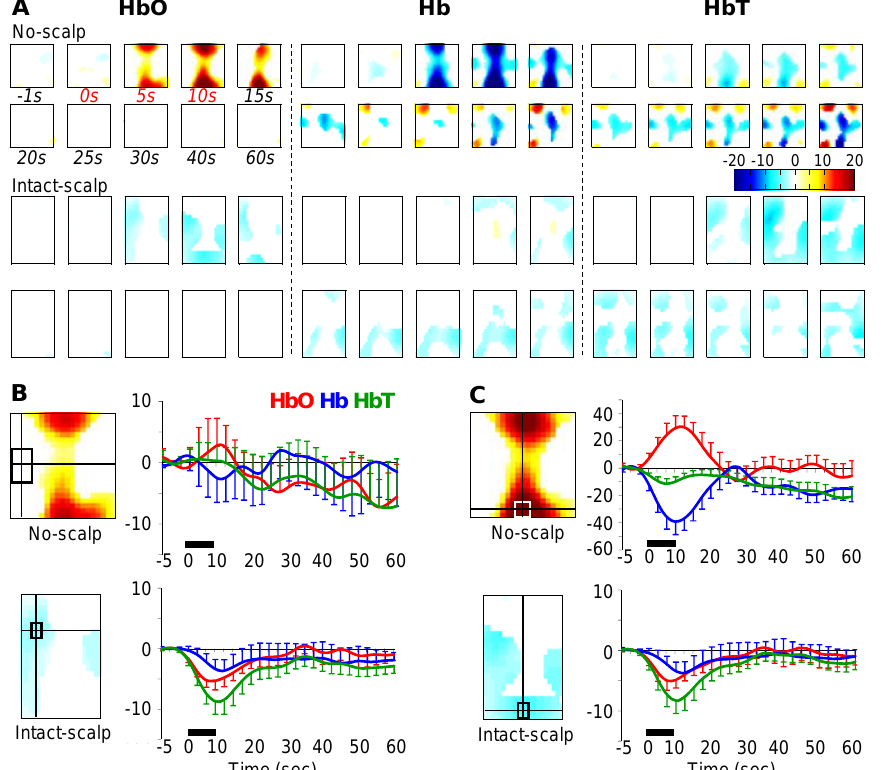
Figure 4. Brushing-induced hemodynamic changes in the no-scalp [12] and intact-scalp groups. ( A ) reconstructed images at typical time points. Unit: microMolar; ( B ) time series of hemodynamic changes at a contralateral ROI. Location of ROI in the intact-scalp group was determined in the example image (left inset) at 5 s in HbO; location of ROI in the no-scalp group is the same as in Figure 3B; ( C ) time series of hemodynamic changes at a middle posterior ROI. Locations of ROIs were determined in example images (left insets) at 10 s in HbO. Black bars: 10-s stimulation